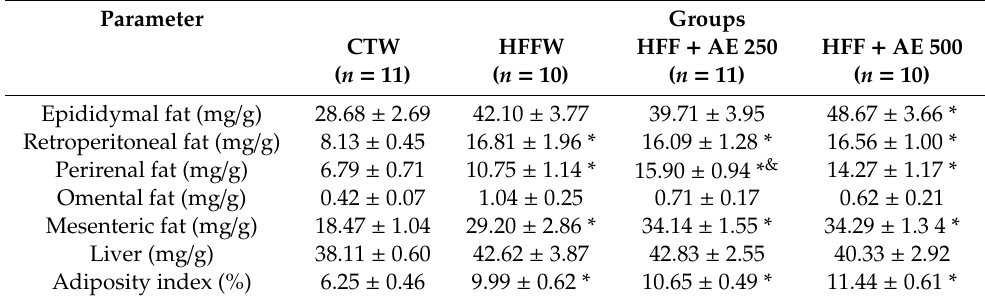
Table 3. The e ff ects of AE on the fat pads, adiposity index, and liver weight. Parameter